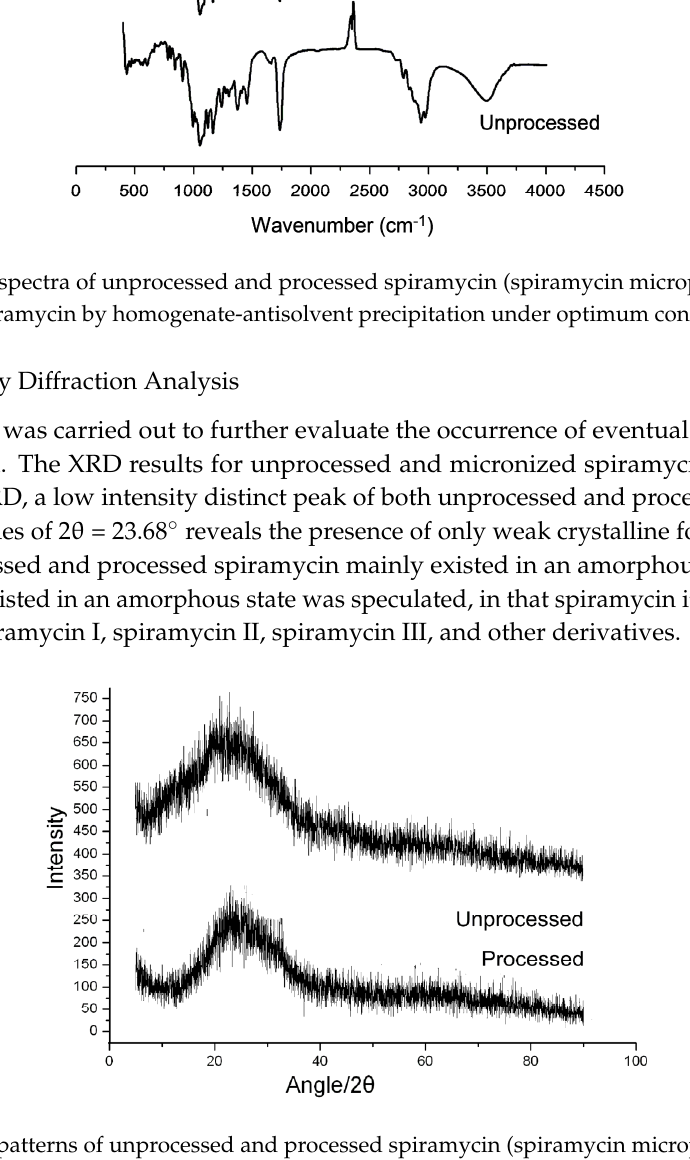
Figure 7. Scanning electron micrographs of ( a ) unprocessed and ( b ) processed spiramycin (spiramycin microparticles are the micronized spiramycin by homogenate ‐ antisolvent precipitation under optimum conditions), and particle size distribution of processed spiramycin under optimized experiment conditions ( c ). 3.4. Solvent Residues Analysis In pharmaceutical products, the solvent residue is a serious problem and is under consideration. In this work, the preparation of spiramycin particles was realized by the HAP process using the International Conference on Harmonization (ICH) class III solvent DMSO with low toxicity [43]. As shown in Figure 8, the residual DMSO content in the spiramycin (prepared using DMSO as the solvent) was determined by GC analysis, DMSO with retention time of 8.45 min, and a standard curve of Y = 341.68 X + 2.02 ( R 2 = 0.9997), where Y is the peak area and X is the DMSO concentration. The residual DMSO concentration in the spiramycin microparticles was calculated to be 0.33%, according